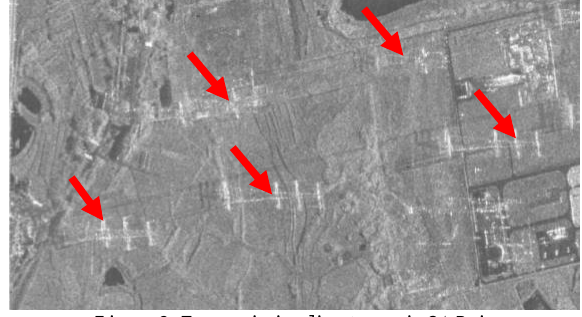
Figure 2. Transmission line tower in SAR image